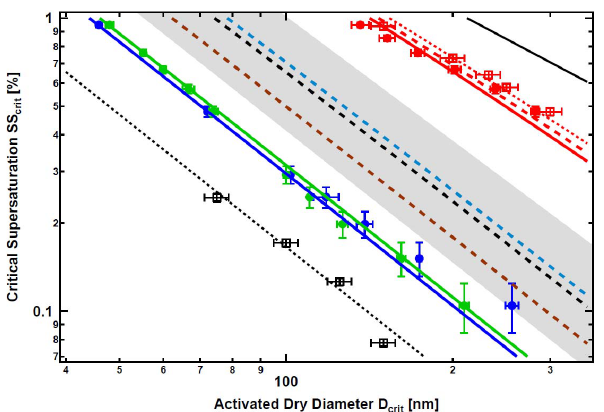
Fig. 9. Critical supersaturation as function of the activated dry di- Figure 9. Critical supersaturation as function of the activated dry diameter: CaCO 3 (red dots), ameter: CaCO 3 (red dots), Ca(HCO 3 ) 2 (s) (blue dots), and mixed Ca(HCO 3 ) 2 (s) (blue dots), and mixed CaCO 3 /Ca(HCO 3 ) 2 (s) (green dots). Red, blue and green CaCO 3 /Ca(HCO 3 ) 2 (s) (green dots). Red, blue and green solid lines solid lines represent one parameter Köhler calculations assuming κ =0.0019, κ =0.16 and represent one parameter K¨ohler calculations assuming κ =0.0019, κ =0.14, respectively. For comparison results of Sullivan et al. (2009b) are given for CaCO 3 κ =0.16 and κ =0.14, respectively. For comparison results of Sul- (red open squares) with κ = 0.0011 (red dotted line) and Ca(NO 3 ) 2 (black open squares) with livan et al. (2009b) are given for CaCO 3 (red open squares) with κ = 0.051 (black dotted line). The shaded area comprises the range of expectation for κ =0.0011 (red dotted line) and Ca(NO 3 ) 2 (black open squares) activation of atmospheric mineral dust according to Koehler et al. (2009). The dashed lines with κ =0.051 (black dotted line). The shaded area comprises the are one parameter Köhler representations of their suggested median κ of 0.03 (black), Arizona range of expectation for activation of atmospheric mineral dust ac- Test Dust ( κ = 0.025, blue) and Saharian Dust ( κ = 0.054, brown) (Koehler et al. 2009). The cording to Koehler et al. (2009). The dashed lines are one parameter red dashed line represents the average κ CO3 based on the combination of this study and of K¨ohler representations of their suggested median κ of 0.03 (black), Sullivan et al. (2009b). Arizona Test Dust ( κ =0.025, blue) and Saharian Dust ( κ =0.054, brown) (Koehler et al., 2009). The red dashed line represents the av- erage κ CO based on the combination of this study and of Sullivan 3 et al.